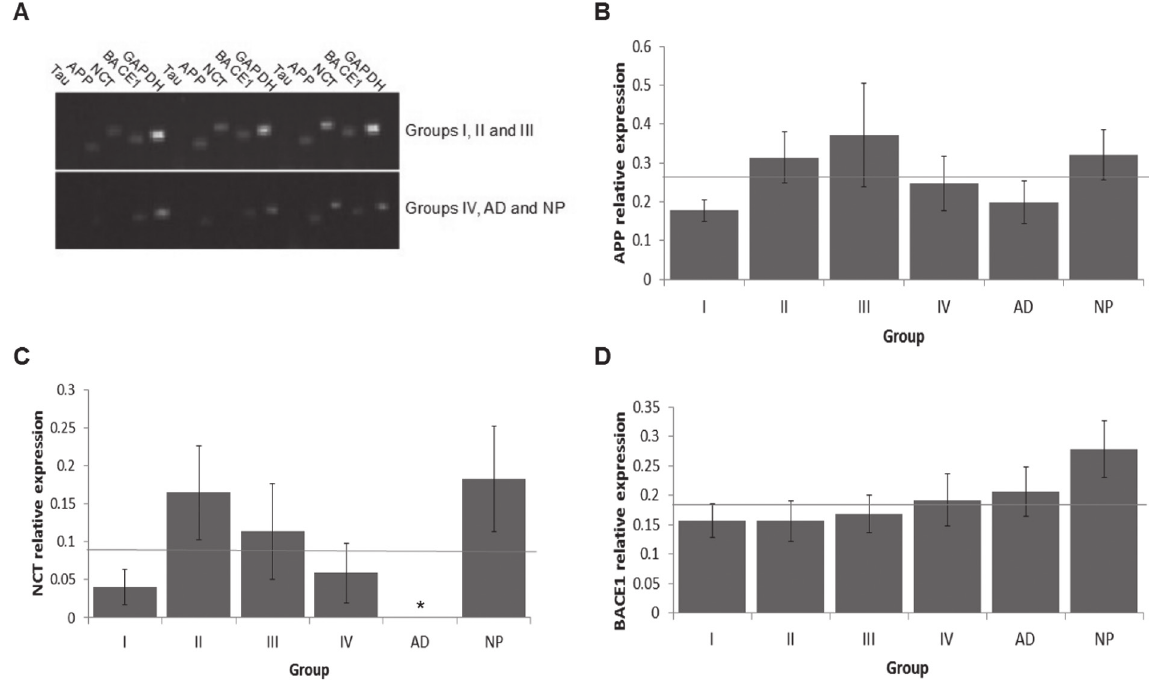
Figure 2 - Expression analysis. (A) Agarose gel of PCR products and relative expression of (B) APP, (C) nicastrin (NCT), and (D) β-secretase (BACE1). The thin gray line represents the overall mean. (*)Only NCT in group AD showed a statistical significant difference at p < 0.05 when compared to groups IV and NP.